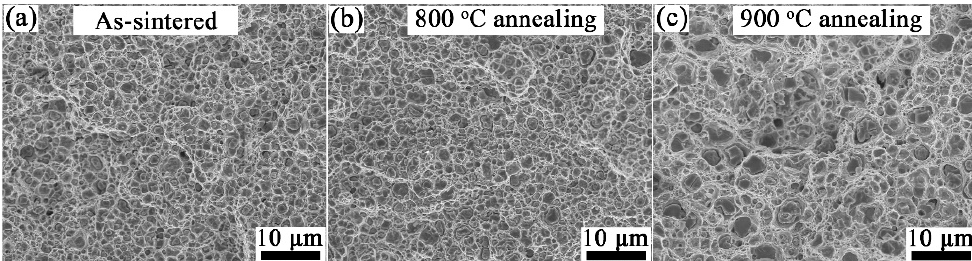
Figure 8. Fracture morphologies of ( a ) as-sintered Cu-1wt%Y 2 O 3 alloy and the samples annealed at ( b ) 800 °C and ( c ) 900